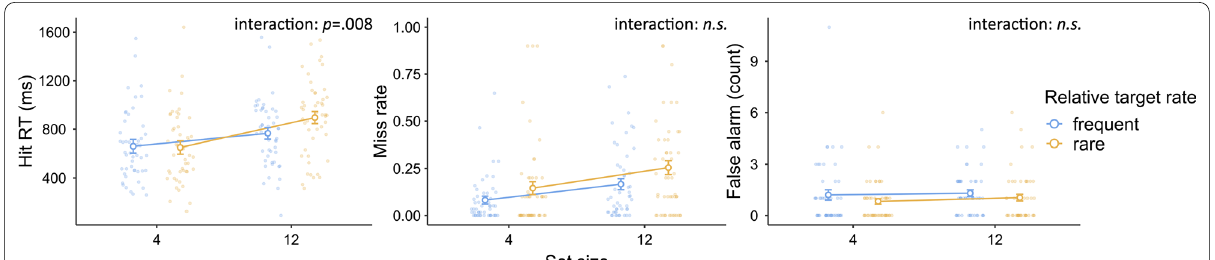
Fig. 9 Experiment 3 results: data by relative frequency of the current target type. Note We rearranged the results by relative target frequency regardless of the current target type. As the graphs show, the search was significantly faster and more efficient in terms of hit RTs when the current target was frequent. There were significantly more misses for the rare target types, but they did not interact with set size. There was no effect on false